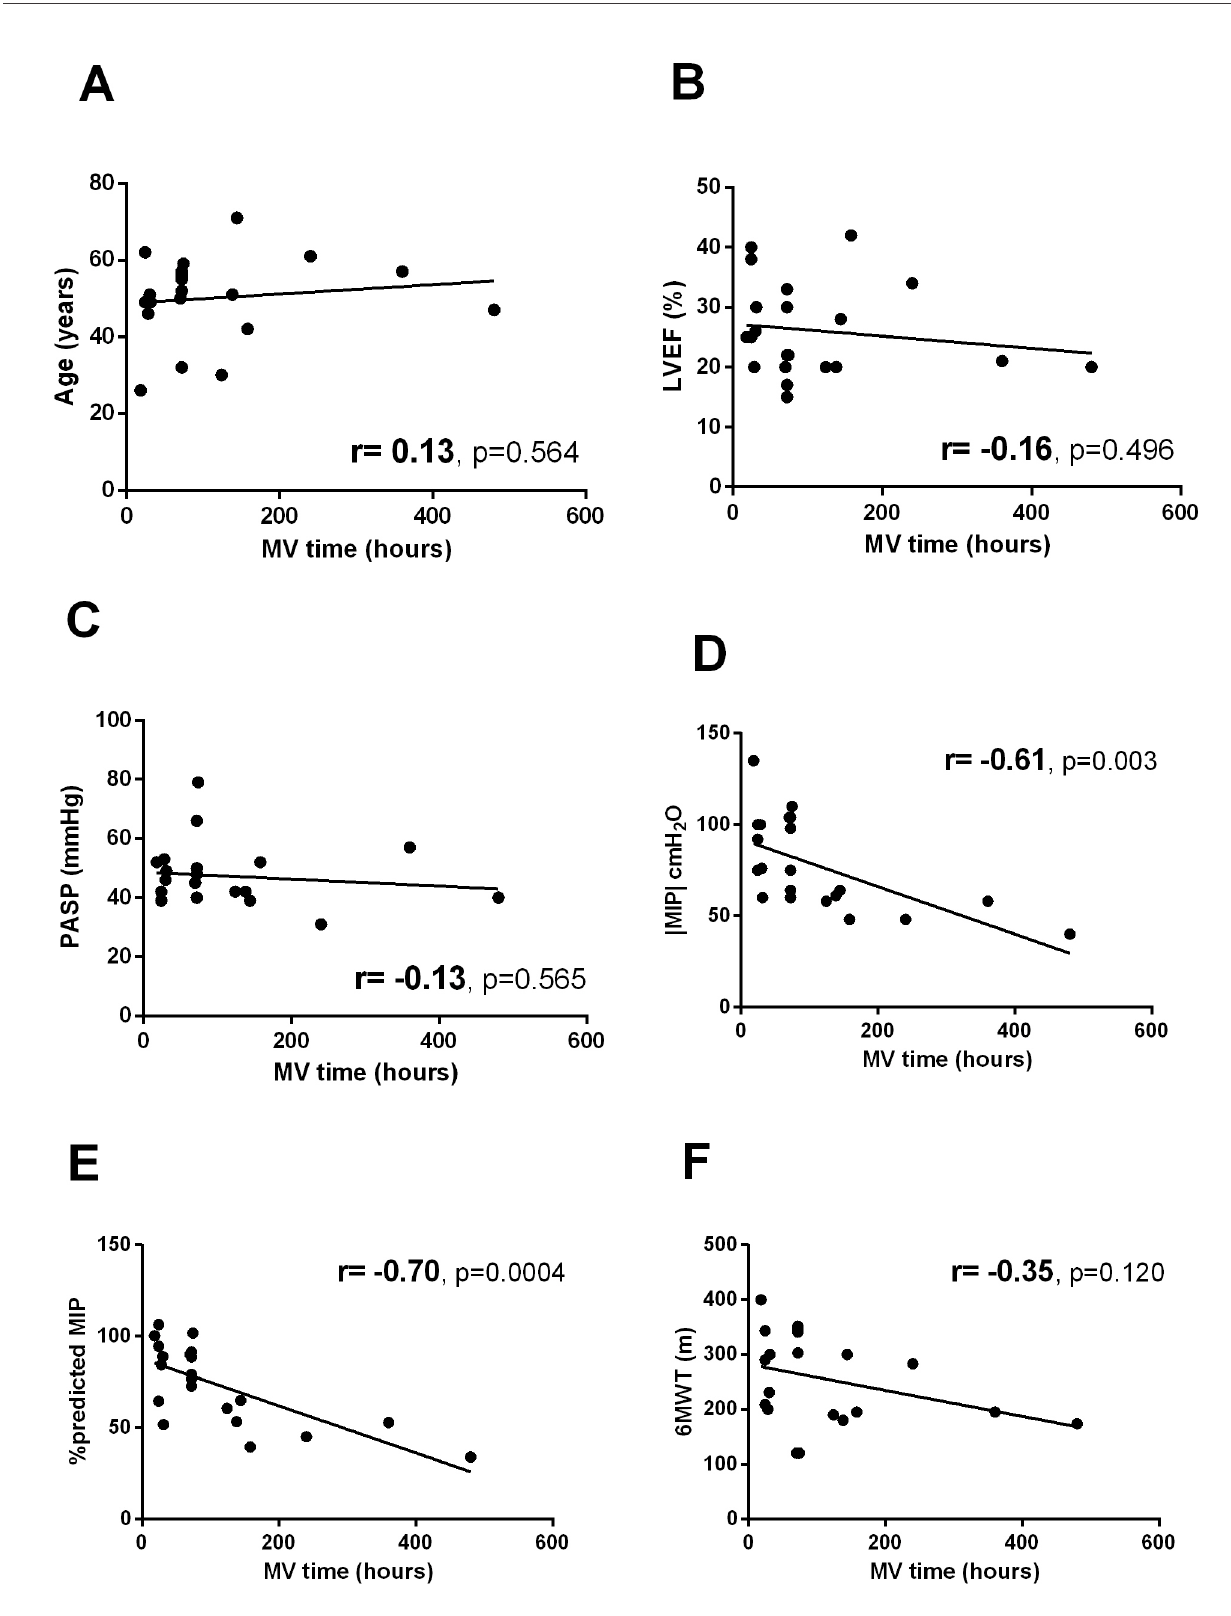
Fig. 2 - Clinical factors related to mechanical ventilation (MV) time. A. Age; B. pulmonary arterial systolic pressure (PASP); C. left ventricular ejection fraction (LVEF); D. maximal inspiratory pressure (MIP); E. percent-predicted MIP; F. six-minute walk test (6MWT)